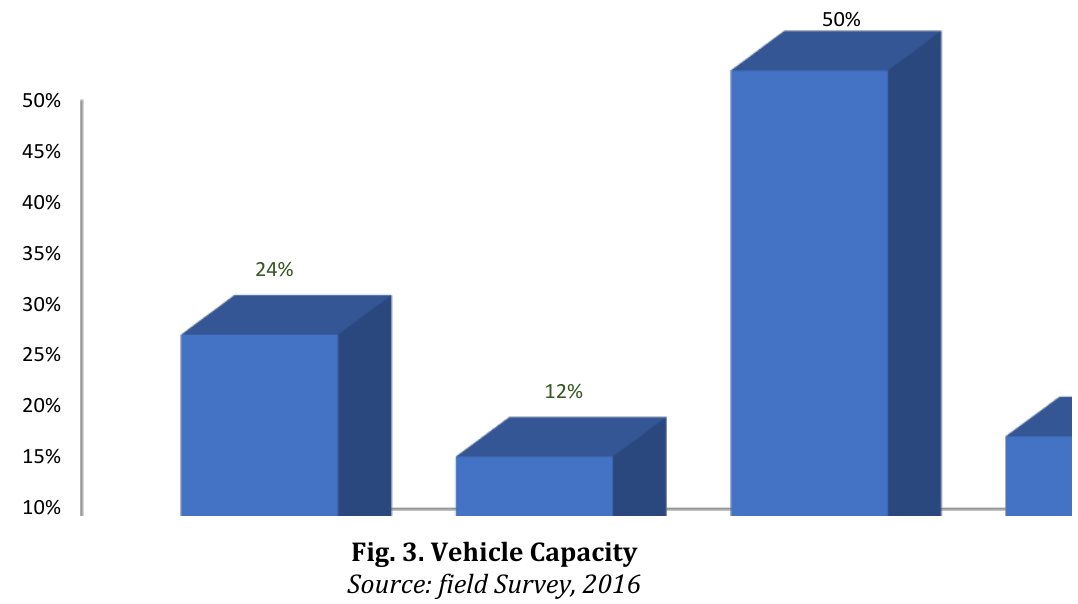
Fig. 3. Vehicle Capacity Source: field Survey, 2016